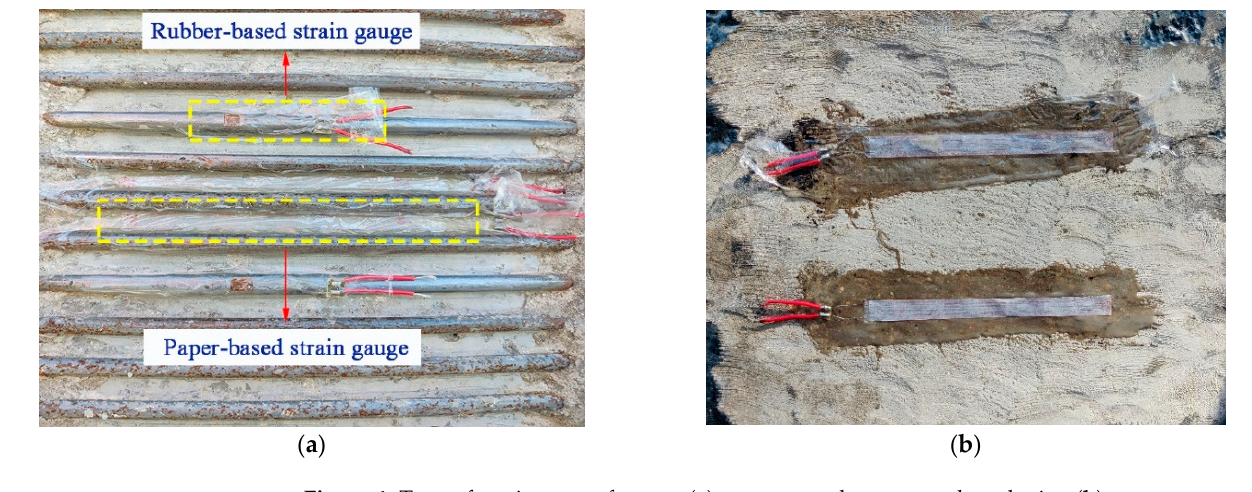
Figure 4. Type of strain gauge for test: ( a ) concrete and prestressed steel wire; ( b ) mortar.